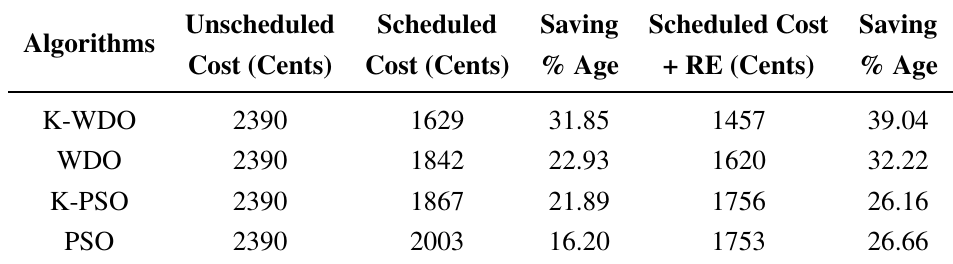
Table 6. Electricity cost